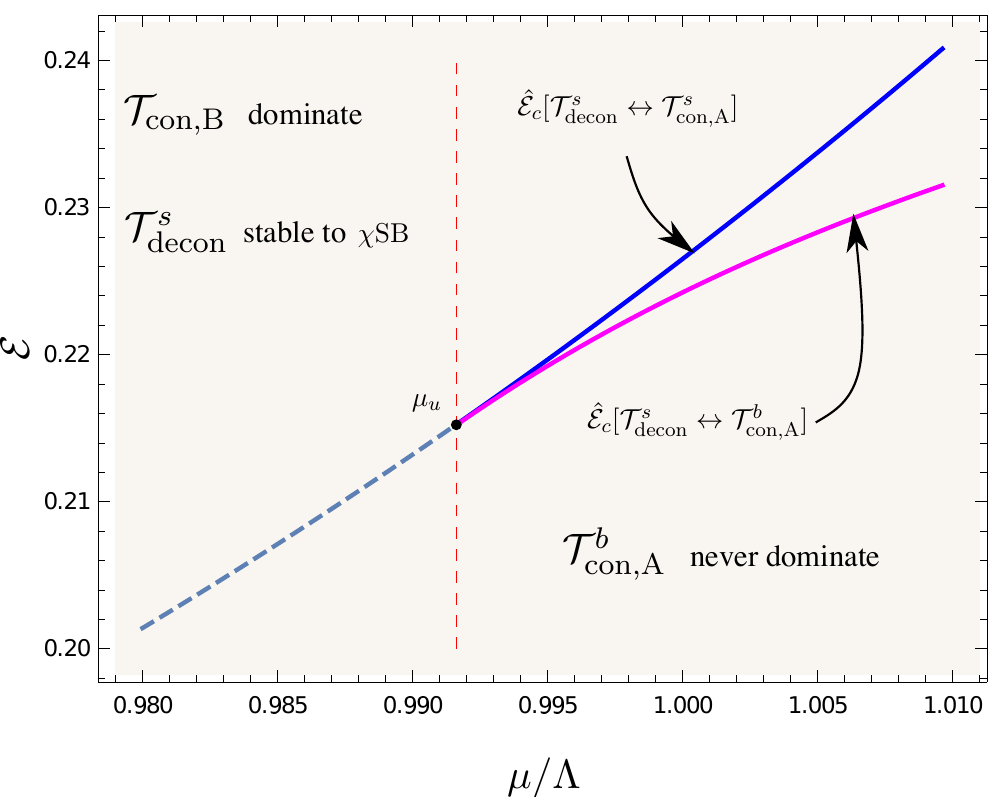
s of states (Klebanov-Tseytlin black holes) for different confine- decon E c T occurs at higher energy densities (compare with figure 25). T con , B